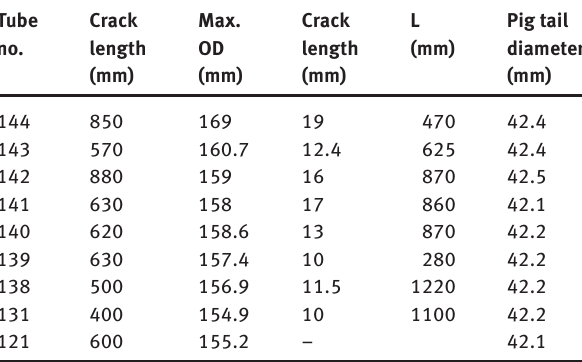
Table 9: Dimensional measurement of the failed reformer tubes and their measured crack lengths [30].